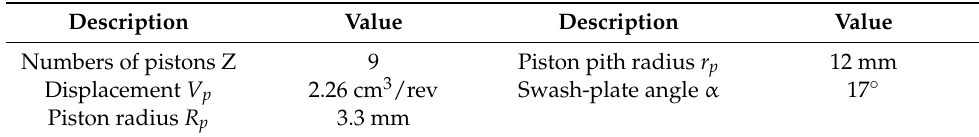
Table 1. Main geometric parameters of the three-port pump.